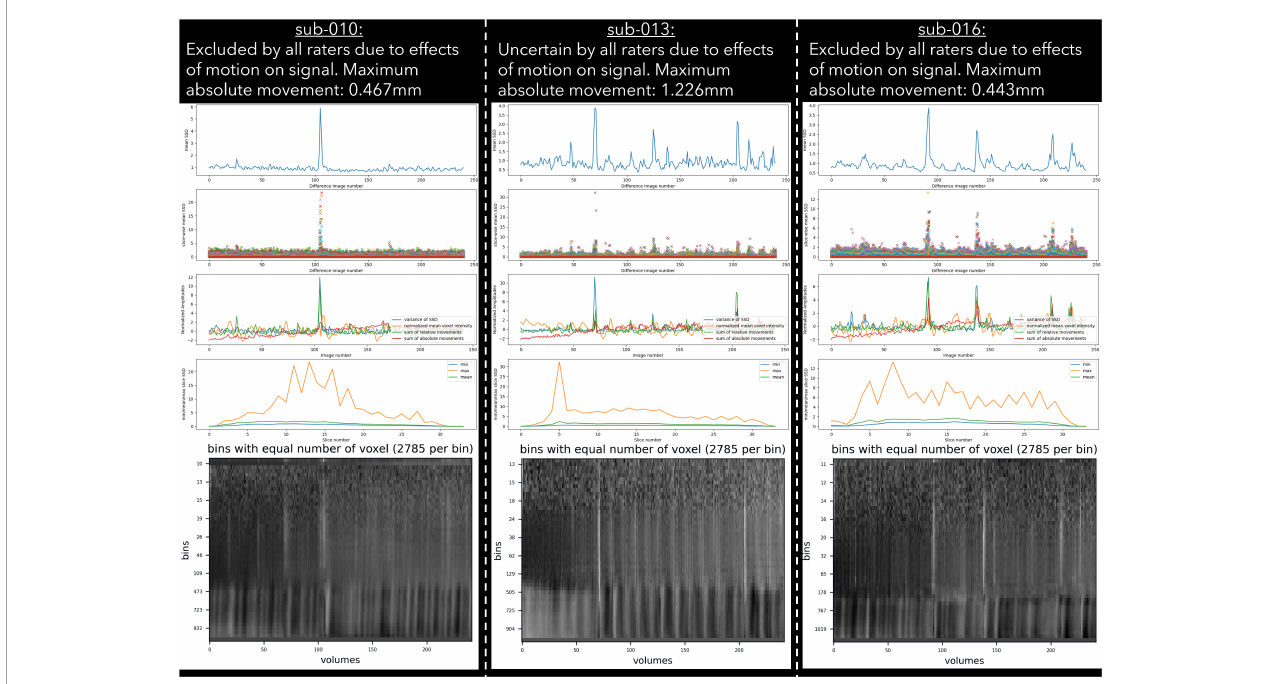
FIGURE3 Example cases of three different types of motion artefacts detected using output from pyfMRIqc. One subject (sub-013) was classified as uncertain by all raters, while sub-010 and sub-016 were classified as exclude by all